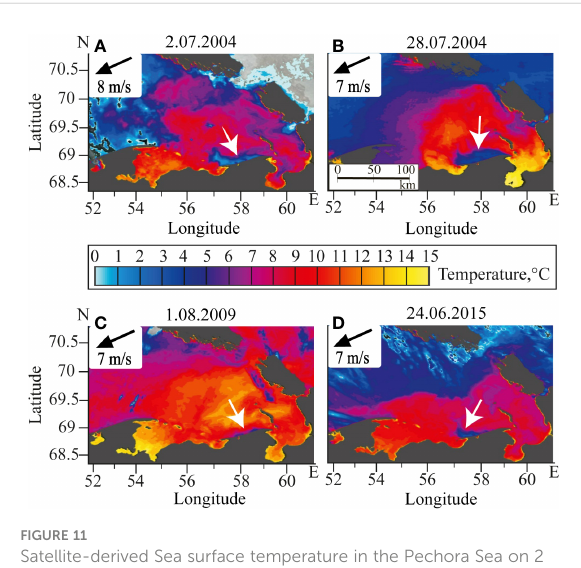
FIGURE 11 Satellite-derived Sea surface temperature in the Pechora Sea on 2 July 2004 (A) , 28 July 2004 (B) , 1 August 2009 (C) , 24 June 2015 (D) acquired by MODIS Terra/Aqua. Areas of upwelling events are indicated by white arrows. Dark grey color indicates land; white color indicates cloud coverage of the study area. Wind directions and velocities averaged during two days preceding the satellite image are shown in the